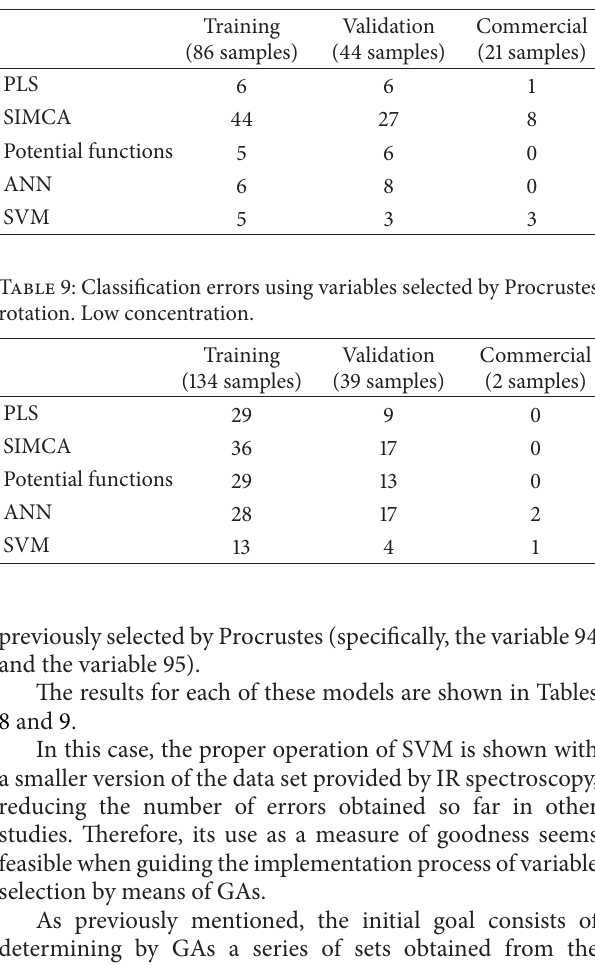
Table 8: Classification errors using variables selected by Procrustes rotation. High concentration.